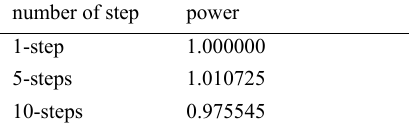
Table 3. performance gain at 30th